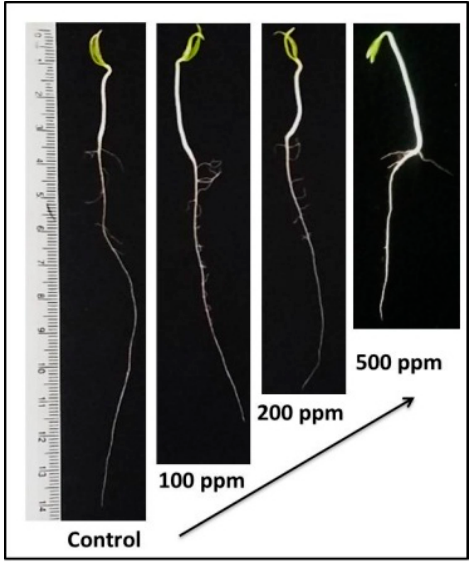
Figure 3. Effect of zinc oxide naoparticles (ZnO-NPs) on growth of Capsicum annuum L. seedlings. Each seedling represented an experimental unit.